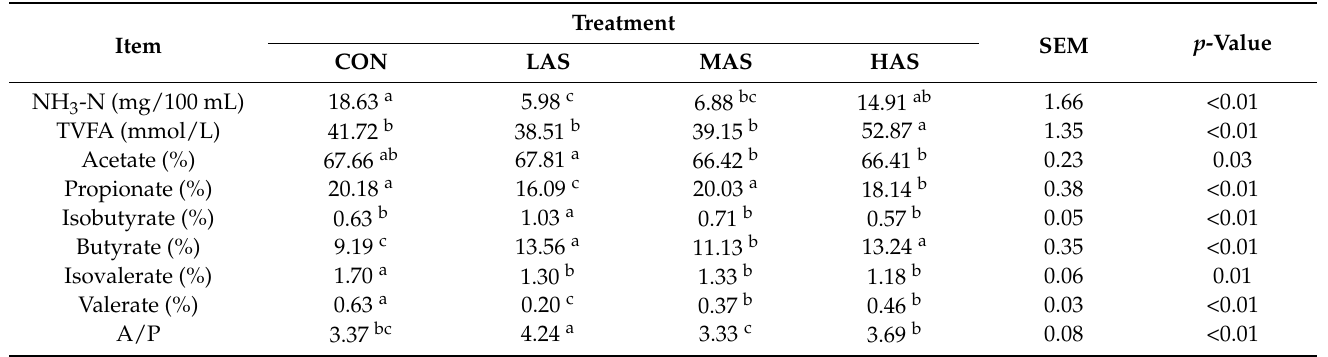
Table 4. Effect of additional sulfur in the diet on in vitro rumen fermentation parameters.